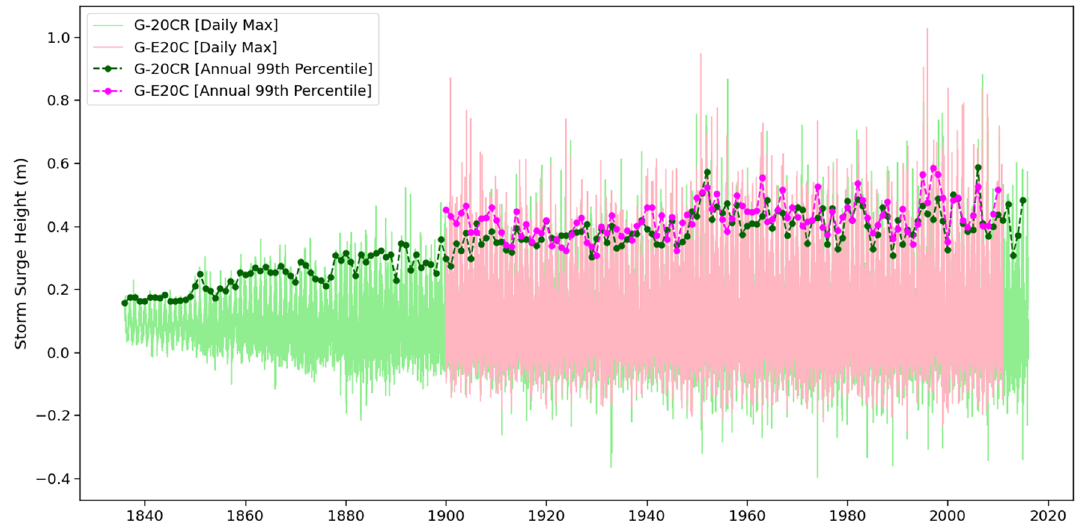
Figure 1. Reconstructed daily maximum surges from G-20CR (green) and G-E20C (pink) and their respective annual 99th percentiles (dashed lines with markers) for the Astoria tide gauge.